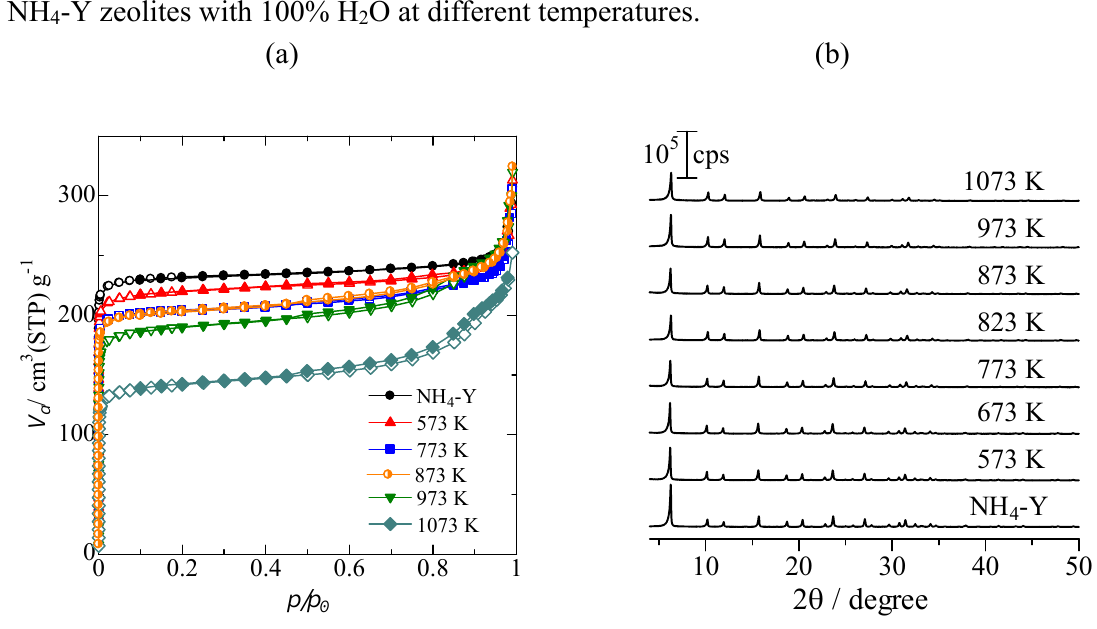
Figure 1. (a) N adsorption isotherms. Open symbols: adsorption branches, closed 2 symbols: desorption branches; (b) XRD patterns of USY zeolites prepared by steaming of NH -Y zeolites with 100% H O at different 4 2